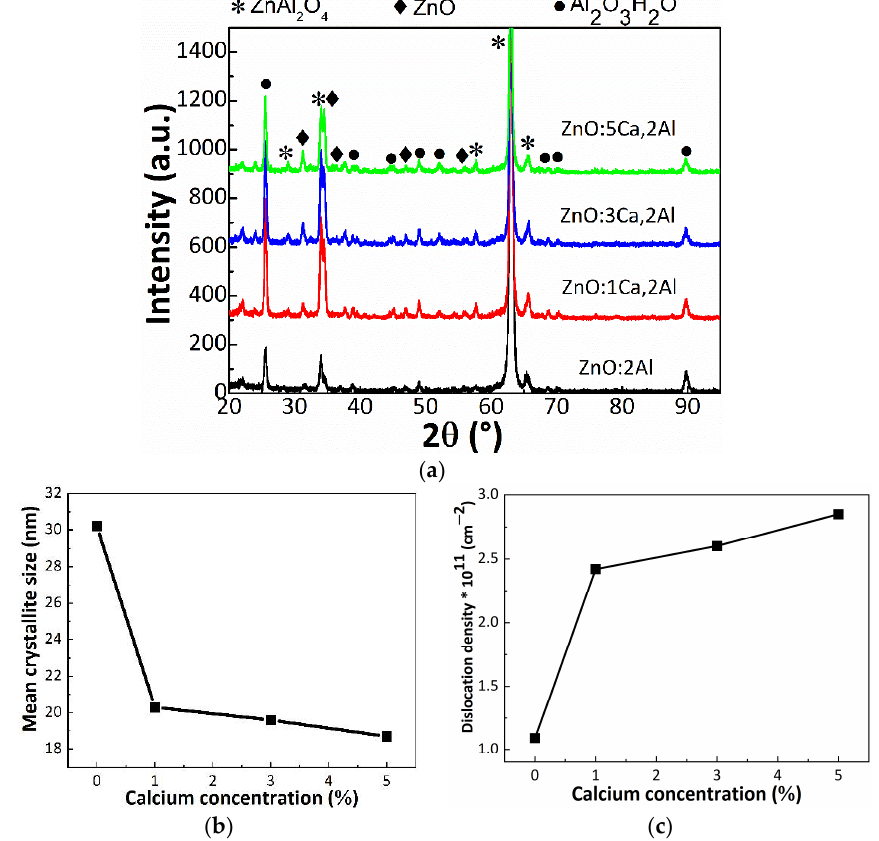
Figure 3 . ( a ) GI-XRD patterns of ZnO:Al 2% and Ca-doped ZnO:Al 2% thin films with: 1, 3 and 5% Ca, ( b ) the mean crystallite size and ( c ) dislocation density of investigated thin films as a function of calcium concentration of the doped ZnO:Al thin films.